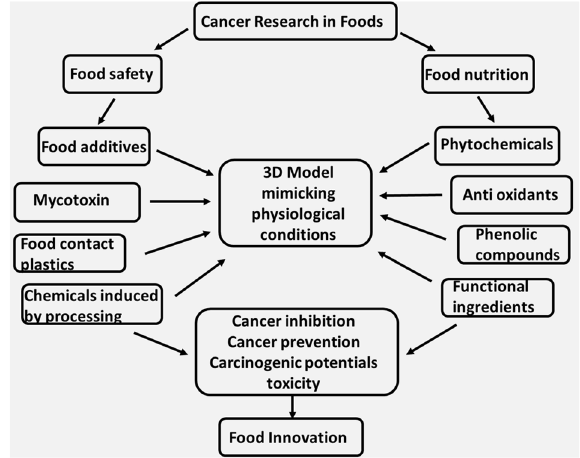
Fig. 3 3D model mimicking in vivo microenvironment enables predictive-ef fi cency of ef fi cacy and toxicity analysis of bioactive food compounds and chemicals. Sample image highlighting the applications of in vitro 3D model systems in cancer research pertaining to food safety and food